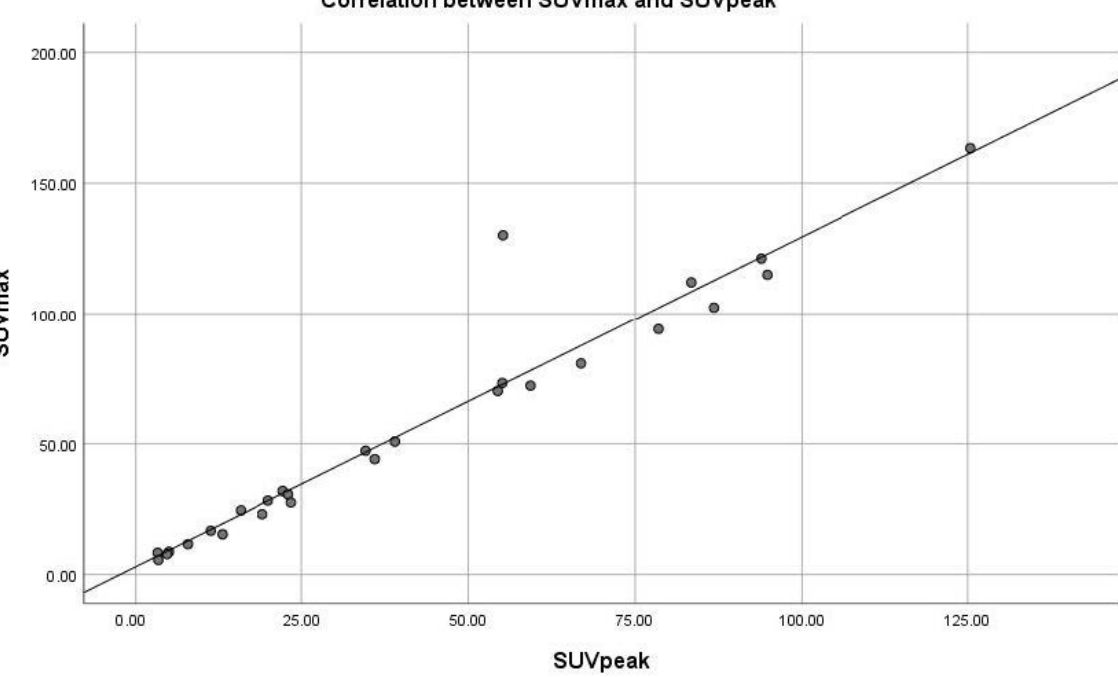
Figure 1. Correlation between SUV max and SUV peak values in NET lesions.